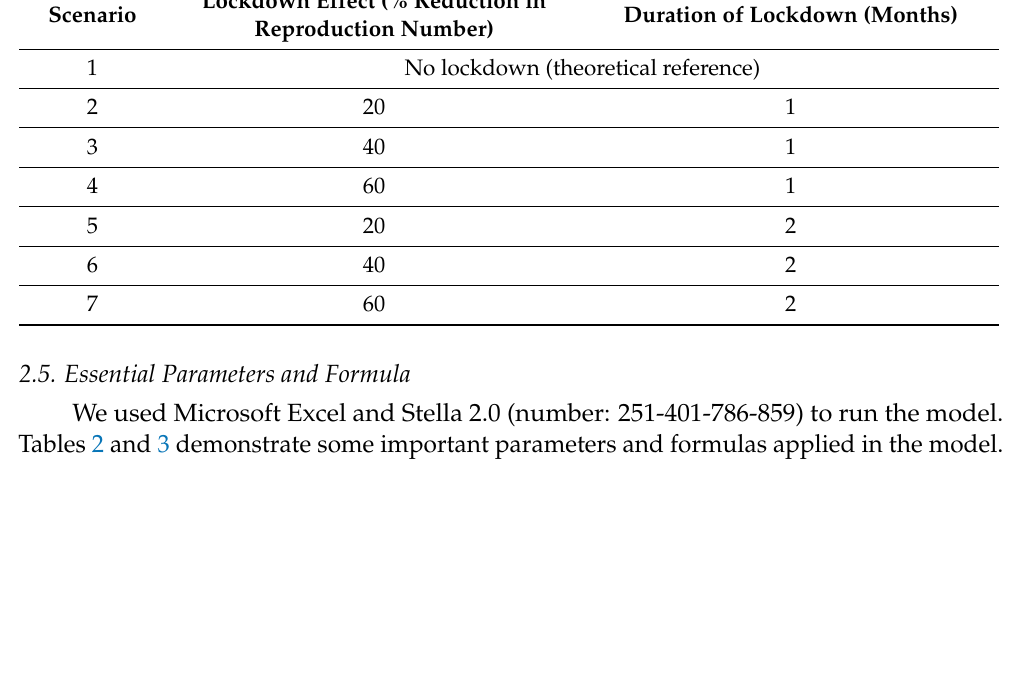
Table 1. Scenarios of